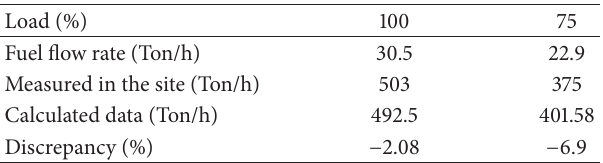
Table 6: Comparison of the calculated steam generation rates with measured